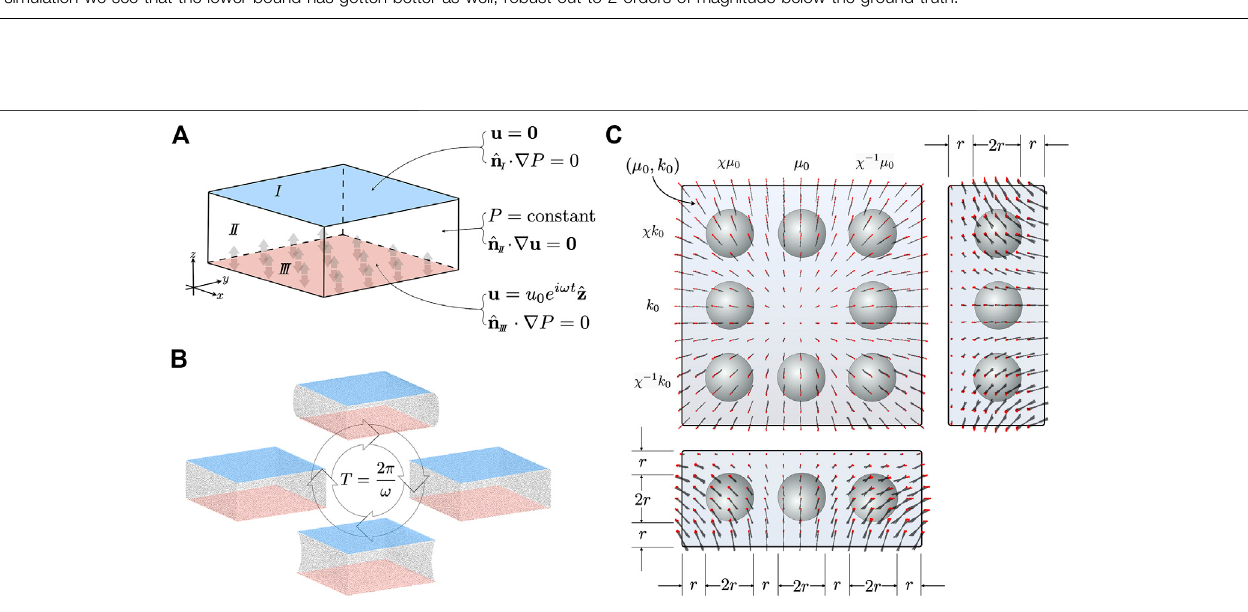
Frontiers in Physics |